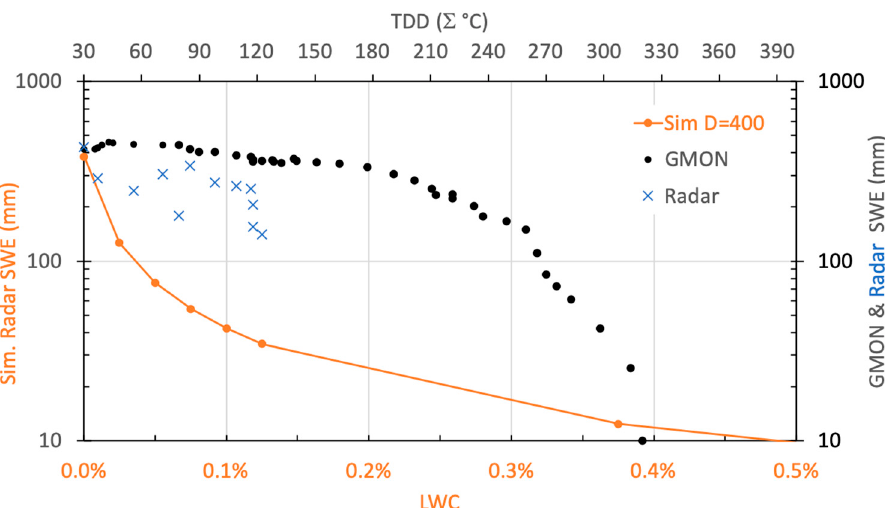
Figure 17. Simulated SWE (orange dots, left axis) as a function of LWC (bottom X axis), and measured SWE using GMON ((black dots) and radar (blue cross) as a function of thawing degree-days (TDD) (top X axis). The top horizontal axis starts on the melting onset. The radar was stopped on April 19, 2017 (TDD = 140 degree-days).